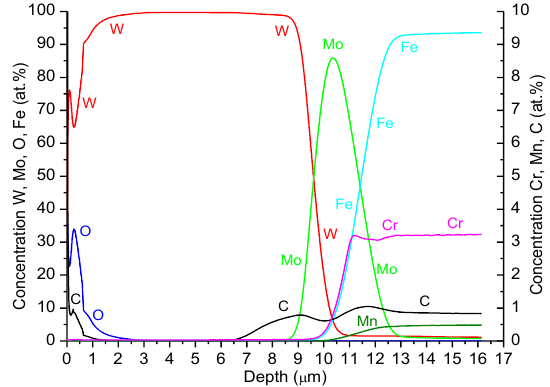
Fig. 4. Depth profiles of W, Mo, Fe, Cr, Mn, C and O measured by Glow Discharge Optical Emission Spectroscopy (GDOES) on W-coated sample made of W1.4901 steel. Near the surface of the sample (0…8 µm), we have almost pure tungsten (W). The molybdenum (Mo) interlayer is found in a depth of approx. 10 µm. For depths > 12 µm we find the expected composition of W1.4901 steel (Fe, Cr, C, Mn